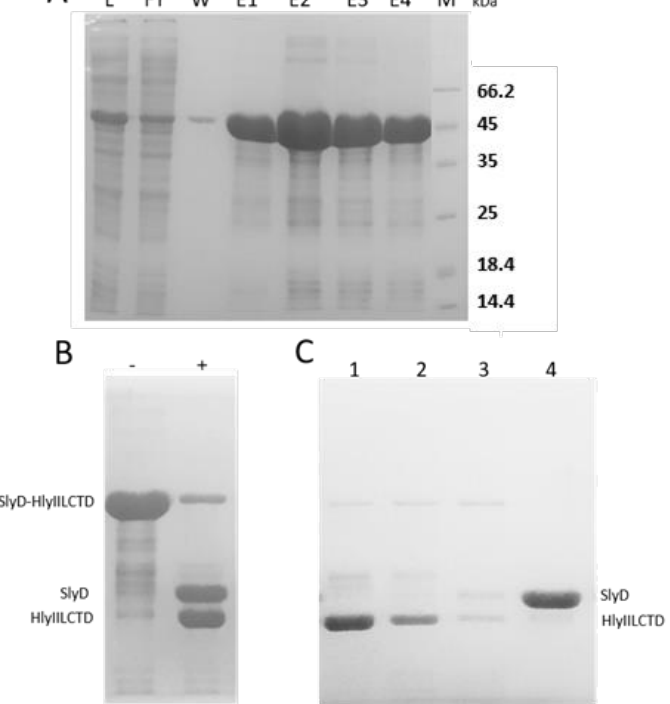
Figure 3. Purification of HlyIILCTD under native conditions. ( A ) Purification of the SlyD–HlyIILCTD fusion protein on Ni-NTA agarose. L, fraction of the clarified lysate of E. coli BL21 (DE3) pTSL–HlyIILCTD; FT, flow through; W, fraction of washing with buffer T with 50 mM imidazole; E1–E4, fractions of elution with buffer T with 300 mM imidazole; M, protein marker. ( B ) The result of proteolysis of SlyD–HlyIILCTD by TEV protease: −, protein fraction before TEV protease treat- ment; +, protein fraction treated with TEV protease overnight at 6 °C. ( C ) Profile of protein elution of HlyIILCTD and SlyD in a DEAE-Sepharose Fast Flow column (1–4). Elution volumes in 1.5 mL steps.